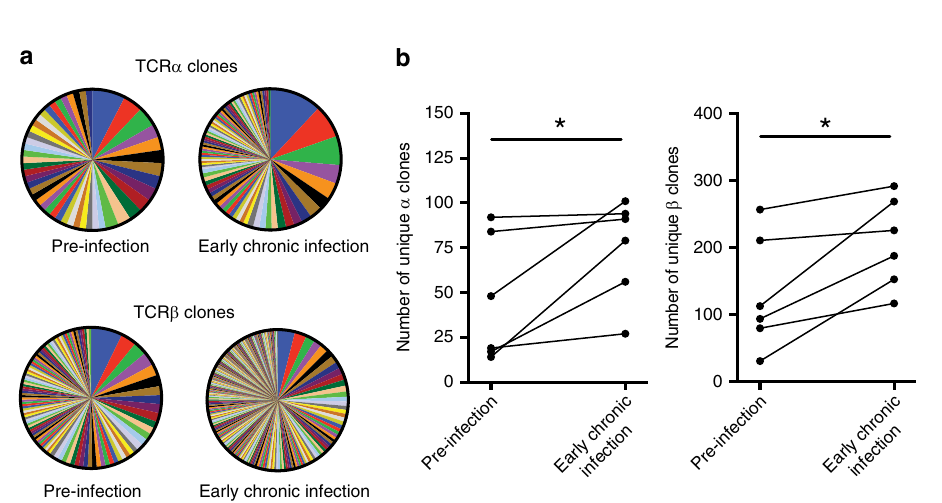
Fig. 4 TCR repertoire diversity of MAIT cells before and after acute HIV-1 infection. RNA-Seq was performed on sorted MAIT cells from PBMC samples at pre-infection and early chronic post-infection time points in the acute capture cohort ( n = 6). a TCR α and TCR β clonal sequence diversity of MAIT cells before and after HIV-1 infection in one representative donor. b Change in the number of MAIT cell TCR α and TCR β clones detected before and after HIV-1 infection. * p < 0.05, Wilcoxon Signed Rank test. MAIT cells are identi fi ed as CD161 ++ V α 7.2 + cells within CD3 + CD14-CD19- live lymphocytes. Donors analyzed here are a subset of donors analyzed in Fig. 2. Post-infection time point corresponds with early chronic HIV infection (85 days since fi rst positive test for HIV-1